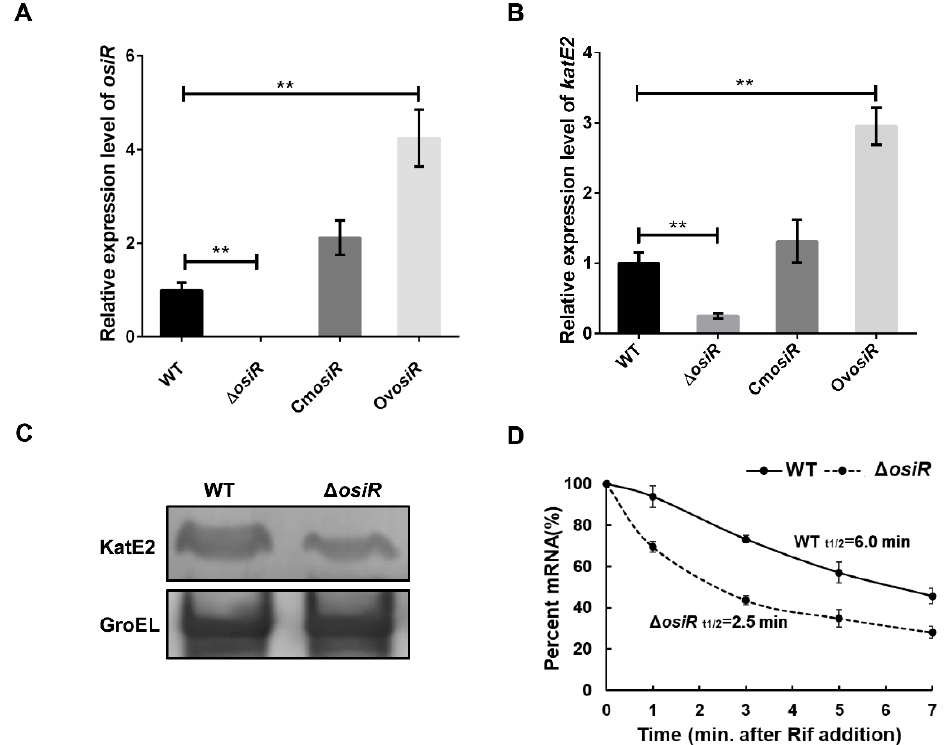
Figure 5. Deletion of osiR leads to a decrease in katE2 expression. ( A ) and ( B ) qRT-PCR analysis of osiR and katE2 in WT, Δ osiR , Cm osiR and Ov osiR . All experiments were performed three times, and the results are represented as the mean ± standard deviation. Statistical analyses were performed using a Student’s t -test. Statistical significance is indicated as follows: **, p value < 0.01. ( C ) Western blot analysis of the KatE2 protein in WT and Δ osiR . GroEl protein served as a loading control; ( D ) determination of the katE2 mRNA half-life in WT and Δ osiR under oxidative stress conditions. The data shown are the averages of three biological replicates. Error bars represent standard deviations.